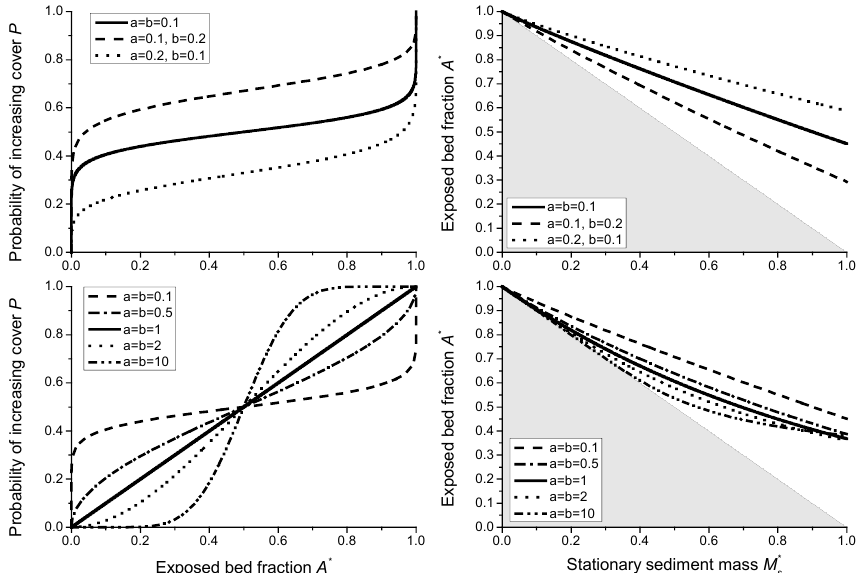
Figure 3. Examples for the use of the regularized incomplete Beta function (Eq. 11) to parameterize P , using various values for the shape parameters a and b . The choice a = b = 1 gives a dependence that is equivalent to the exponential cover function. Grey shading depicts the area where the cover function cannot run due to conservation of